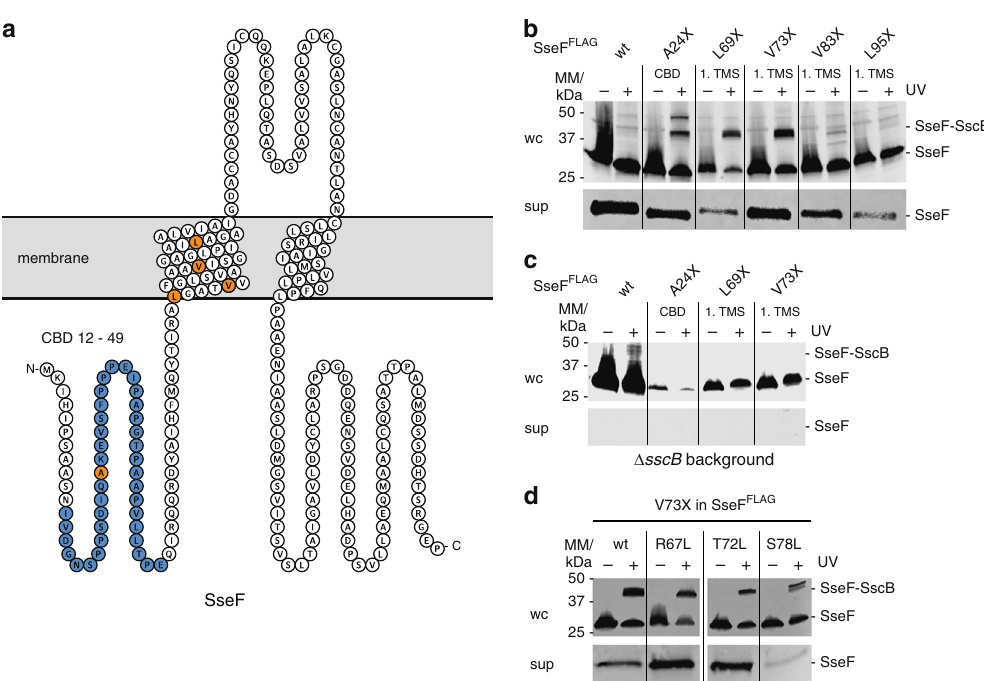
Fig. 5 Protein-protein interaction analysis of SseF and SscB by in vivo photocrosslinking a Protter 39 visualization of SseF presenting predicted TM topology, chaperone binding domain (blue), and positions analyzed by in vivo photocrosslinking (orange). b Immunodetection of SseF FLAG in whole cell lysates with and without UV irradiation (upper panel). pBpa mutations are denotated as “ X ” . T3SS-dependent secretion of mutated SseF was analyzed by SDS PAGE, Western blotting and immunodetection of TCA-precipitated SseF FLAG in culture supernatants (lower panel). c As in b but showing SseF FLAG in a Δ sscB deletion background. d As in b but showing crosslinking position V73 of SseF in mutants harboring various leucine residues on the indicated positions of the fi rst TMS of SseF. A representative result of three independent experiments is shown. CBD chaperone binding domain, WC whole cell lysates, sup culture supernatant, TMS transmembrane